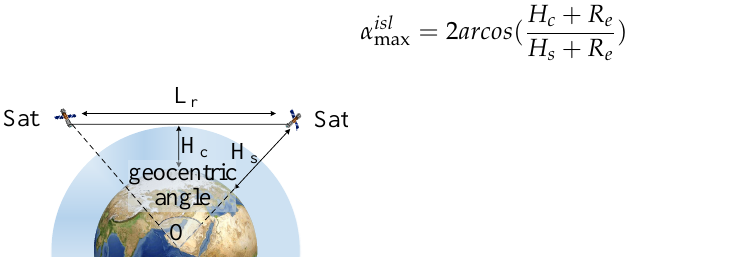
Figure 1. Inter-satellite